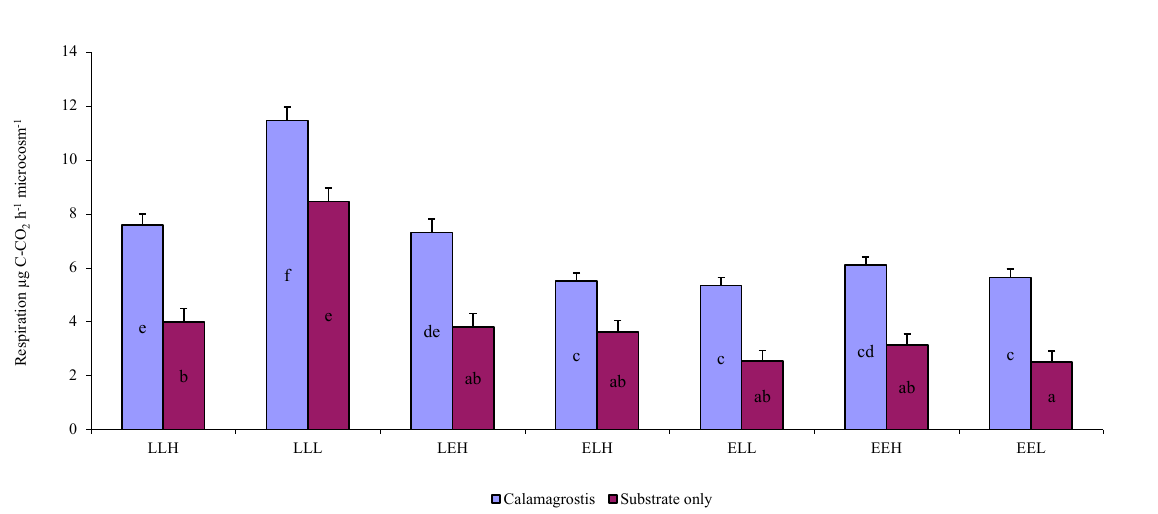
Figure 3. Average respiration of individual treatments with the addition of litter Calamagrostis epigejos (Calamagrostis) or without the addition of litter (Substrate only) for the whole experiment time ( μ g C-CO 2 h − 1 microcosm − 1 ). Error bars are standard deviation. Results are based on repeated measurement ANOVA. If the ANOVA was significant for the soil type, the results of the post hoc test are given (Fischer LSD, p < 0.05). Homogeneous statistical groups are indicated by the same letters.